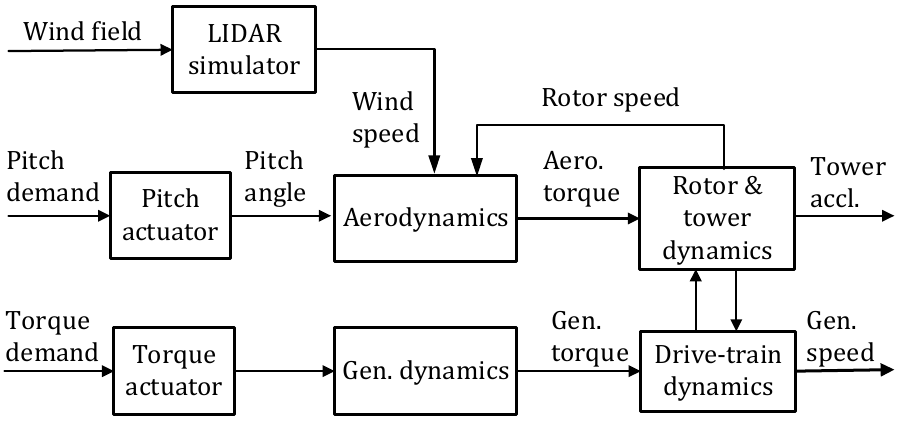
Figure 1. Wind turbine model structure. Table 1. Main parameters of the 5 MW Supergen exemplar wind turbine model.